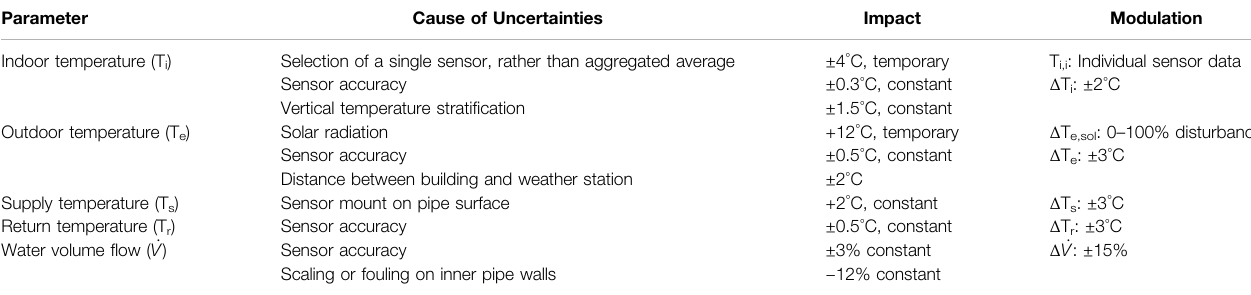
TABLE 1 | Overview of measurement uncertainties and the corresponding sources. Parameter